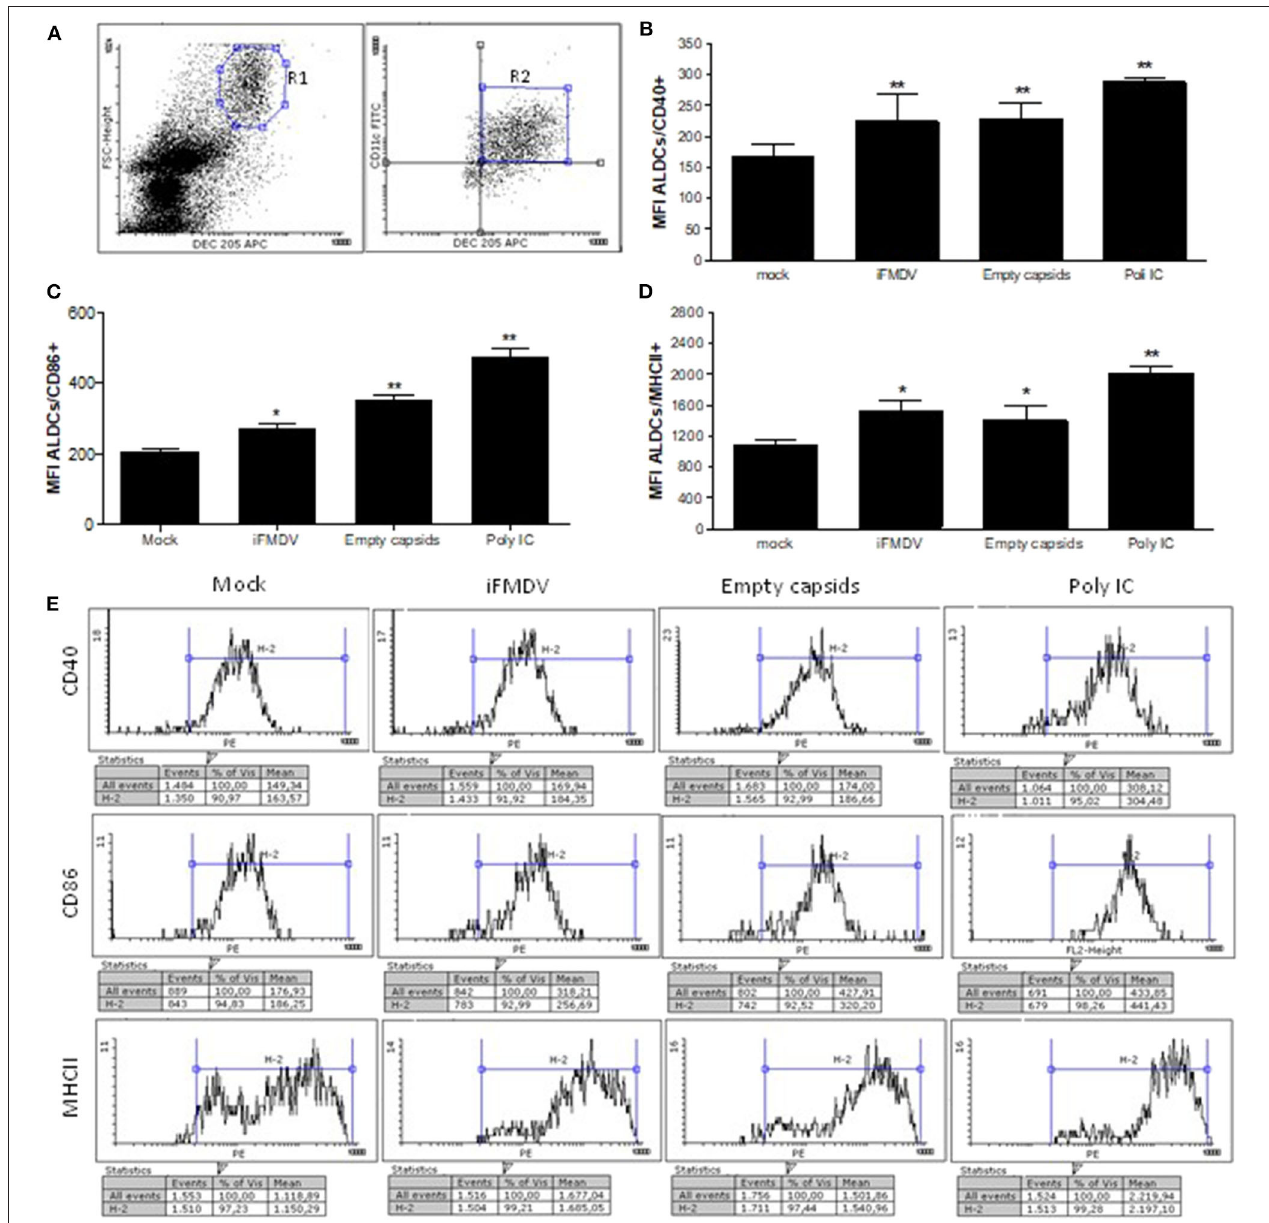
FIGURE 1 | Surface expression of CD40, CD86, and MHCII co-stimulatory molecules on afferent lymph dendritic cells (ALDCs) (FSC high /DEC205 + /CD11c + ) after overnight incubation with iFMDV or empty capsids, is shown. (A) Gating strategy used for cytometric analysis. Co-stimulatory regulation molecules were analyzed in R2 region (B) Regulation of CD40 molecule (C) Regulation of CD86 molecule. (D) Regulation of MHCII molecule. Results in (B–D) are expressed as the mean fluorescence intensity plus Standard Deviation (SD) of four replicates in two independent assays. Mock group were lymph cells incubated with supernatant from non-transfected cells. Poly (I:C) was used as a positive control. *Significant difference p < 0.05, **significant difference p < 0.01. (E) One representative histogram of each group is